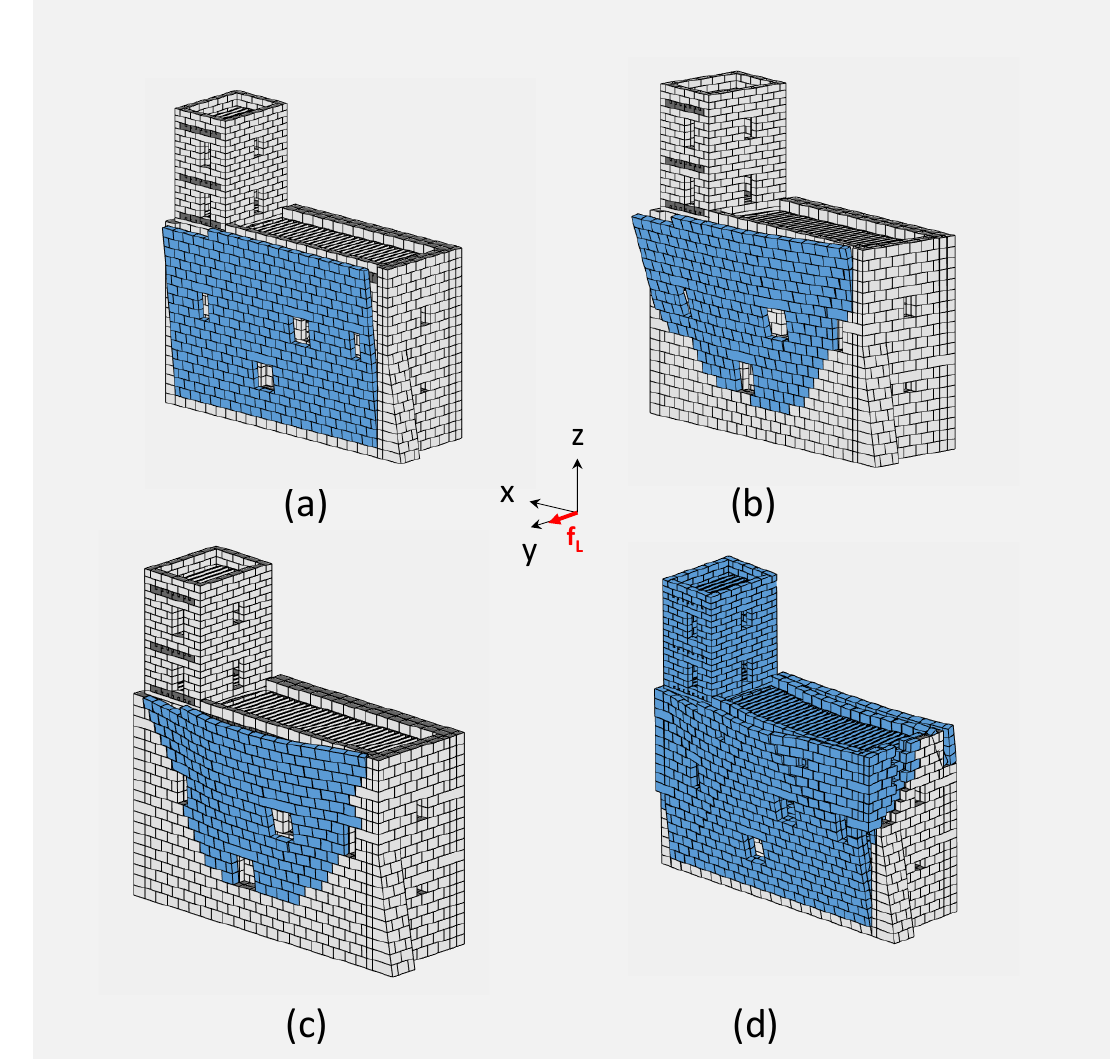
Figure 14. Collapse mechanisms and participating masses (in blue) provided by LiABlock_3D for the load case LC1 (live loads f L along the positive x-axis): ( a ) the castle wing in its present condition; ( b ) retrofitting intervention n.1 (R1); ( c ) retrofitting intervention n.2 (R2); ( d ) retrofitting intervention n.3 (R3). Quoins in red; washer-bearing plates in green.